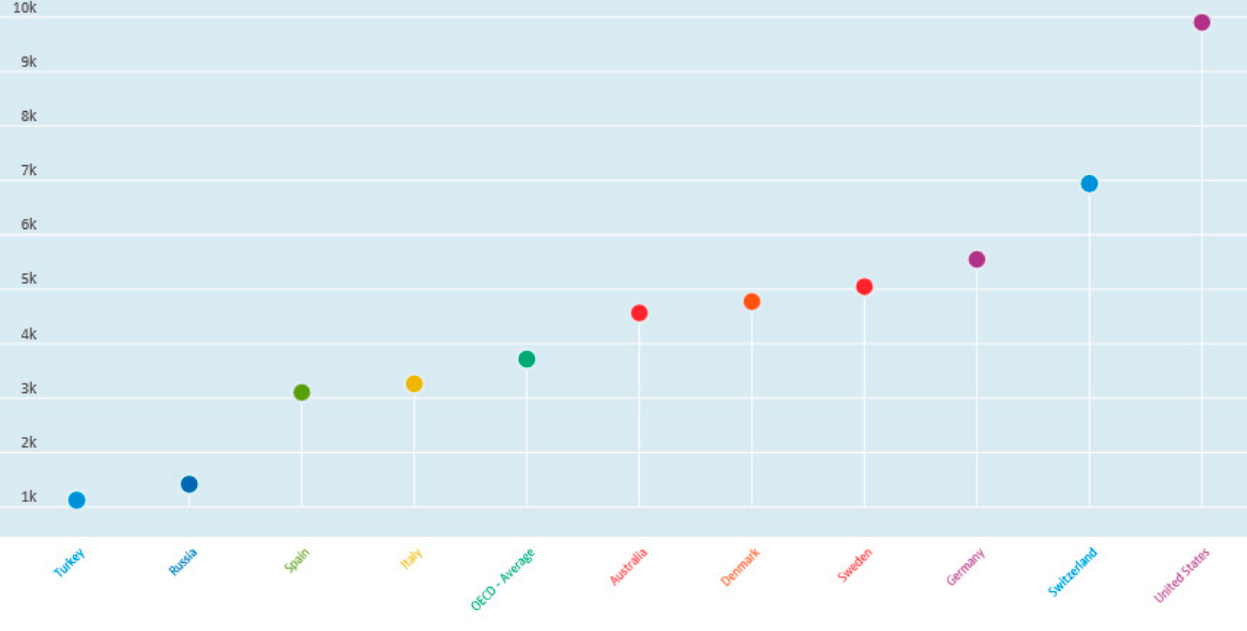
Figure 2. Per capita healthcare spending by country.